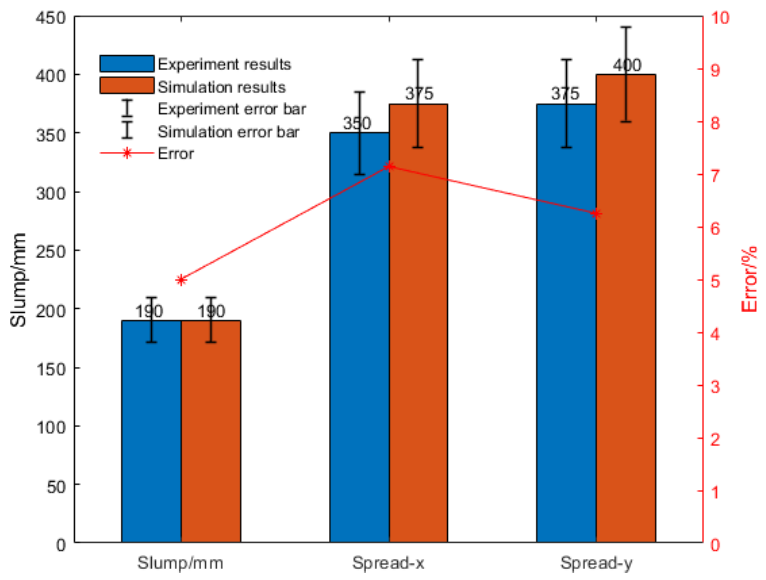
Figure 12. Error analysis of Group 1.